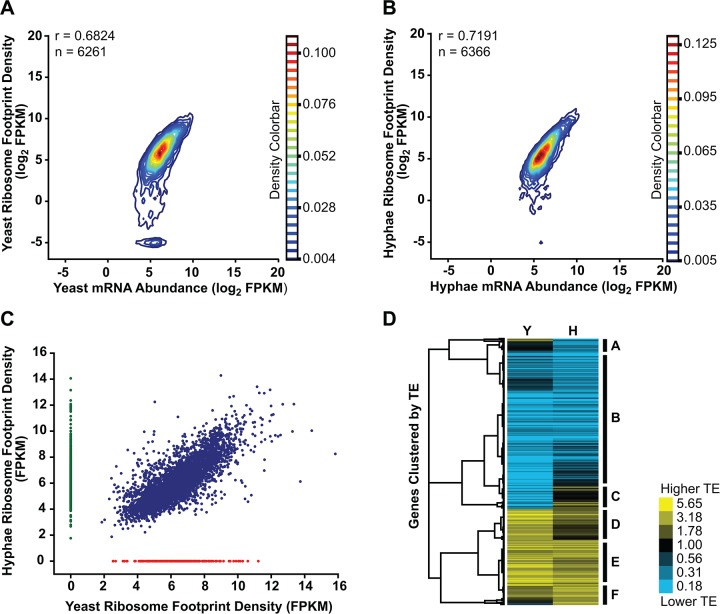
Transcriptional and translational regulation contributes to gene expression in Histoplasma.(A–B) Contour densities of log2 ribosome footprint density and mRNA abundance FPKM values were plotted as Gaussian kernel density estimate distributions for yeast (A) and hyphae (B) for transcripts with raw mRNA counts in coding regions ≥ 128. For mRNA that passed this filter but had no measureable ribosome footprints, ribosome footprint FPKM values were clipped to the lower limit of log2 = -5. Ribosome footprint and mRNA biological replicate data were pooled. Pearson correlation coefficients (adjusted r values) are shown for genes where the footprint FPKM values did not have to be clipped to -5. (C) Ribosome footprint density measurements (FPKM) for yeast and hyphal transcripts with footprint counts ≥ 128 are plotted in blue. Transcripts with raw footprint counts ≥ 128 in one cell state and with differential counts of 5 fold or greater between cell states are plotted in red and green, respectively. These transcript sets represent transcripts predominately translated only in yeast (red) or hyphal (green) cell types. (D) Translationally regulated transcripts were defined as having TE measurements that were differential by log2 1.25 in at least one Hc cell morphology. Transcript TE values meeting this cutoff were then subjected to hierarchical clustering using an uncentered Pearson correlation. Data are displayed as a heatmap of log2 differential FPKM values with yellow representing genes with higher TE values and blue representing genes with lower TE values. Categories A-F are described in the text. Clustered heatmaps are given as S28–S29 Data.